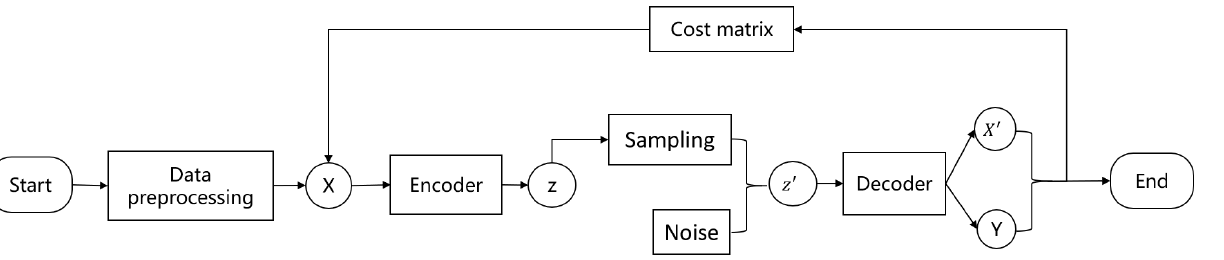
Figure 1. The diagram of the proposed Cost-Sensitive Variational AutoEncoding Classifier algorithm. X denotes the original data, Z denotes the hidden variable, Z ’ denotes the sample of Z , Y denotes the data label, and X´ denotes the reconstruction of the original data. The encoder module is used to obtain the distribution of hidden variable Z from the original data X , the decoder module is used to reconstruct samples and classify them, and the cost matrix module is used to adapt to imbalanced